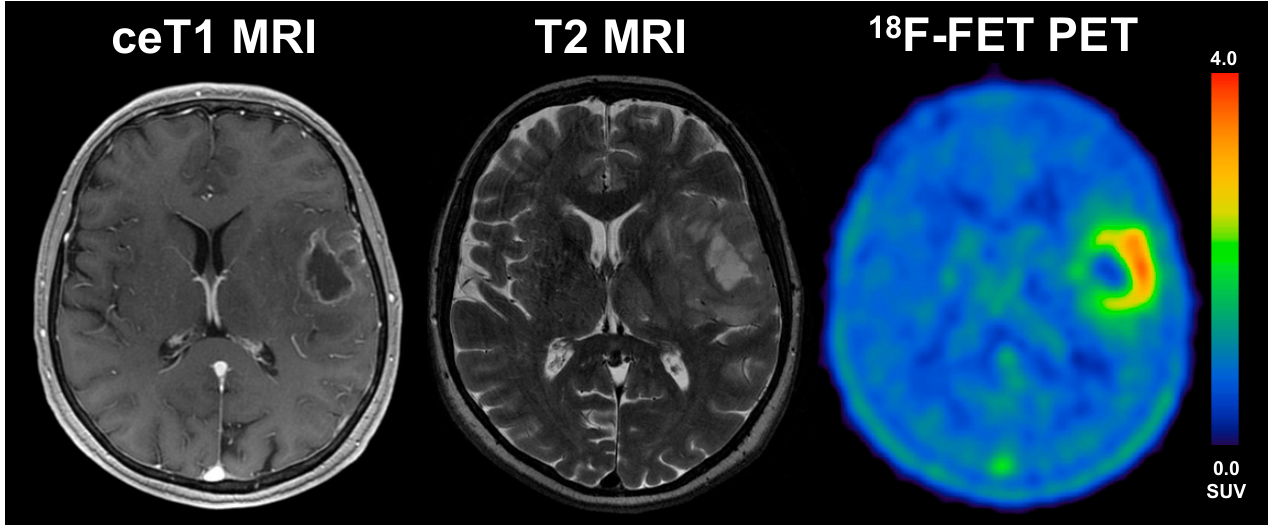
Figure 4. 57-year old female with glioblastoma (WHO grade IV, IDH wildtype, MGMT unmethylated) and an overall survival of 4.9 months (STS). The diameter of CE on T1 MRI was 31 mm, the volume of CE was 6 mL, the BTV in FET-PET was 39.1 mL, the TTP min was 12.5 min and TBR max was 3.9. The patient underwent radiochemotherapy.